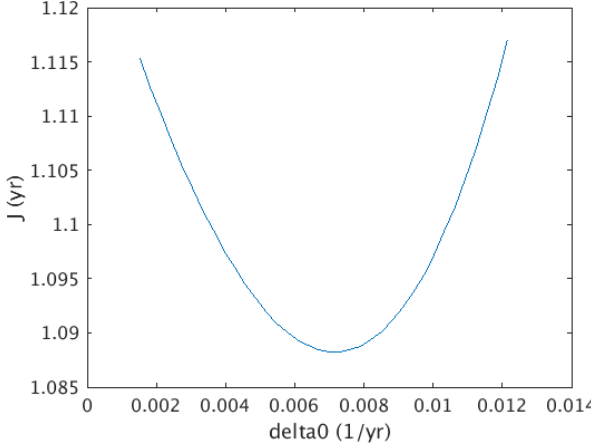
Figure 8. Cost function of layer ages versus (cid:49) 0